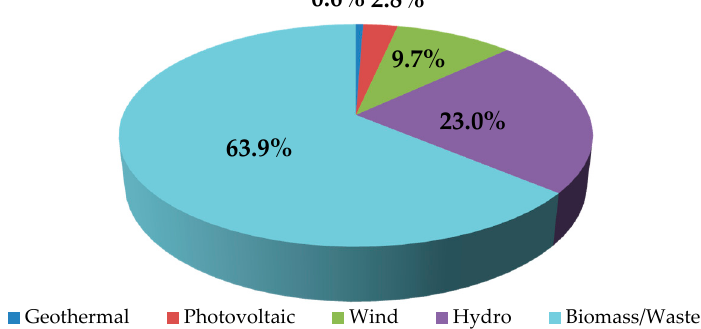
Figure 4. Structure of renewable energy mix in 2015, Source: Own research